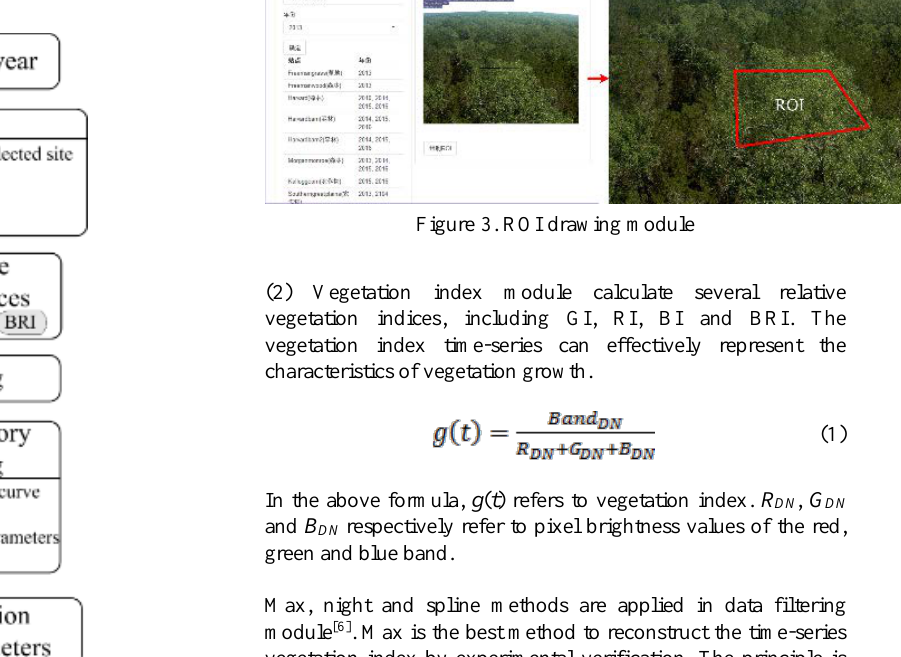
Figure 1. Design of system framework and function modules The system main technical process is shown in Figure 2.